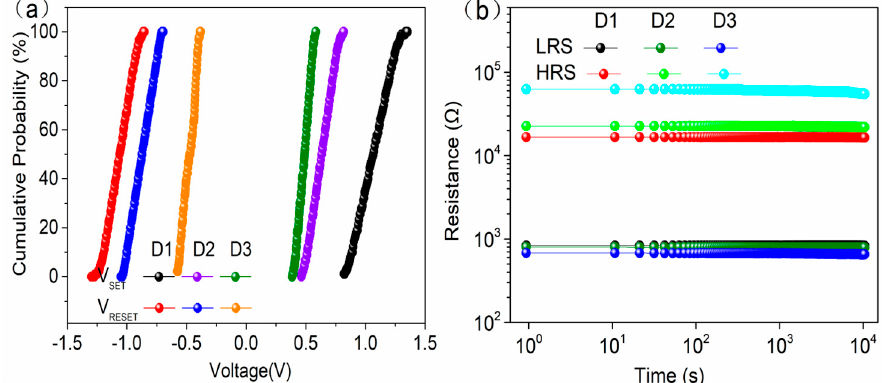
Figure 5. ( a ) Cumulative distributions of SET and RESET switching voltages for the D1, D2, and D3 devices, ( b ) Retention characteristics of the D1, D2, and D3 devices (V Read at 100 mV for each device).